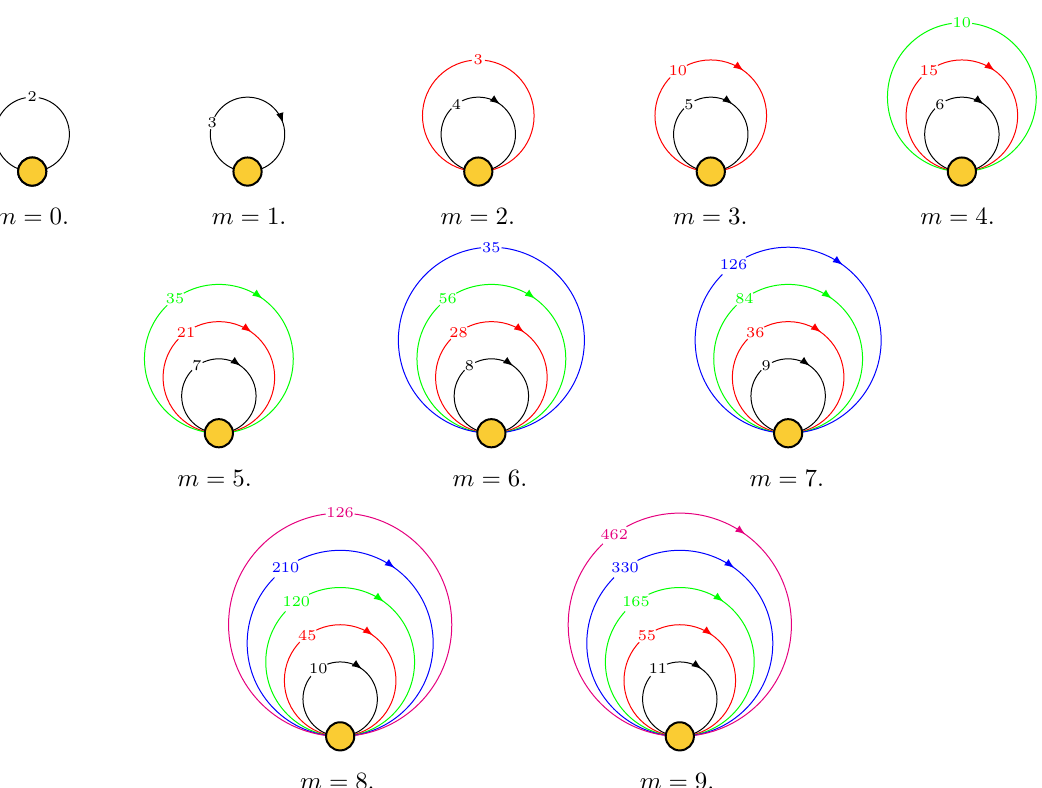
Figure 2. Quivers for C m +2 . The quivers for m = 0 ; 1 ; 2 ; 3 correspond to maximally supersym- metric Yang-Mills theory in d = 6 ; 4 ; 2 ; 0. The multiplicities of (cid:12)elds, i.e. the dimensions of the representations for the SU( m + 2) global symmetry, are indicated on the arrows. For m even, the multiplicity of the outmost (unoriented) line is half the dimension of the corresponding rep- resentation. Black, red, green, blue and purple arrows represent (cid:12)elds of degree 0, 1, 2, 3 and 4,